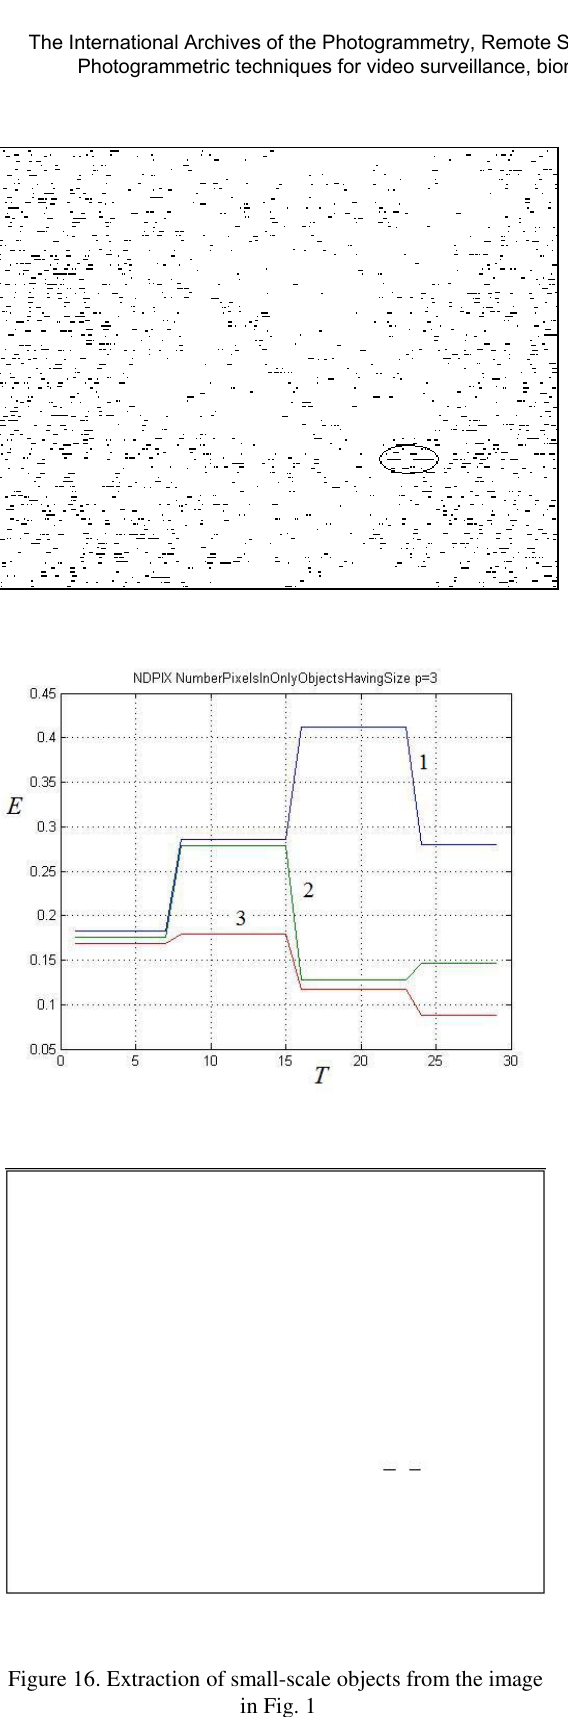
Figure 17. Extraction of small-scale objects from the image in Fig.